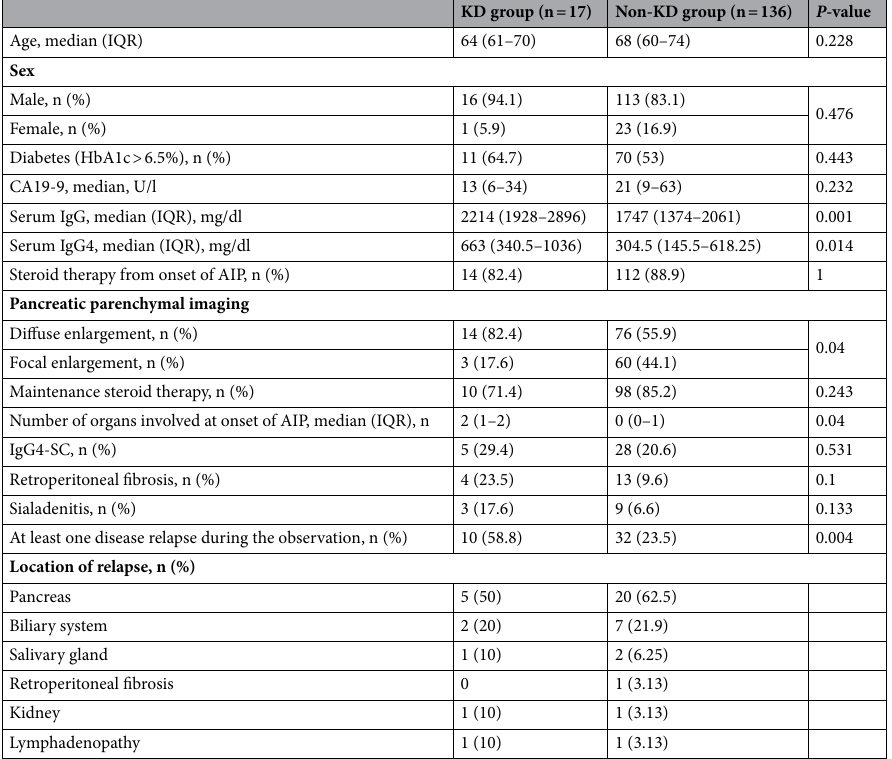
Table 1. Differences between AIP patients with and without renal lesions. KD kidney disease, IQR interquartile range, AIP autoimmune pancreatitis, IgG4-SC IgG4-related sclerosing cholangitis.